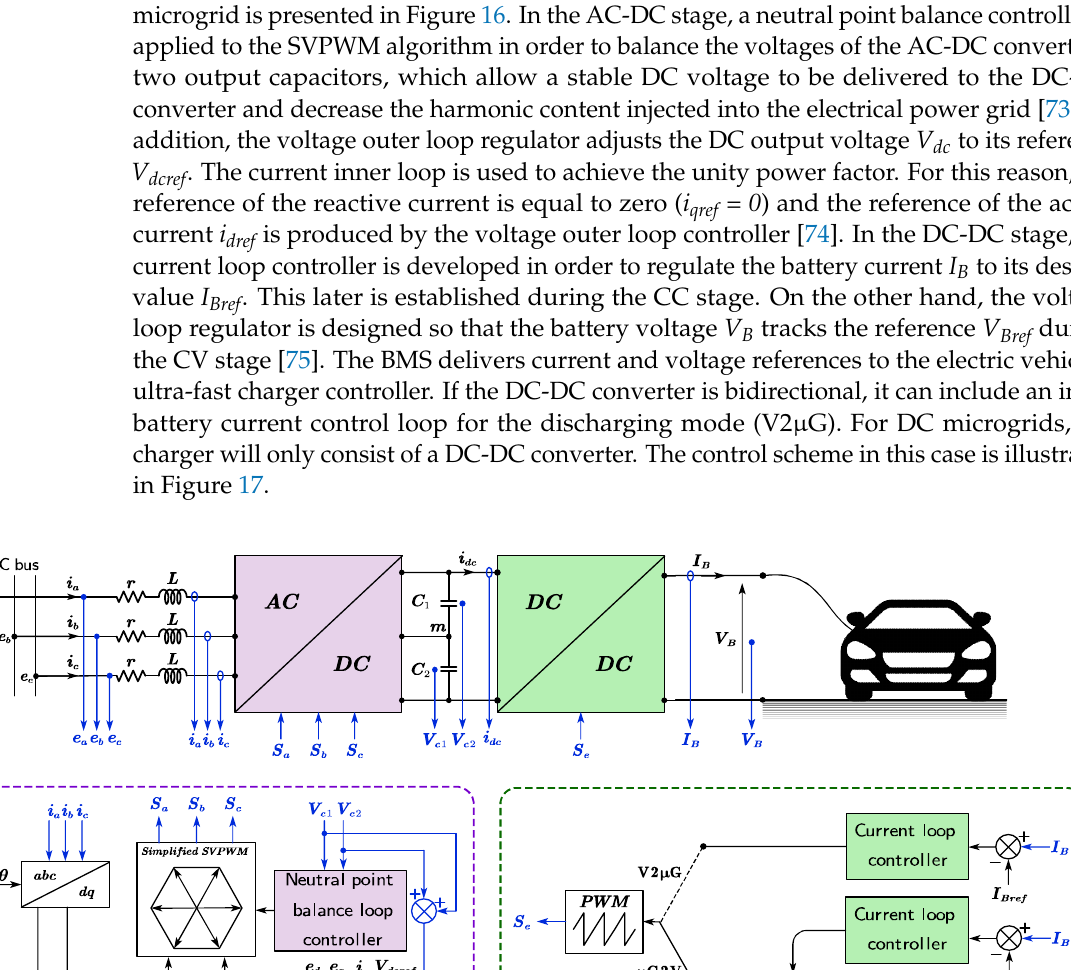
Figure 17. A control structural scheme of the ultra-fast charger integrated into the DC microgrid. Linear control techniques are widely applied to ultra-fast chargers thanks to their flexibility of adjustment, the practical implementation, and the simplified structure. Vari- ous types of linear controllers are available: Proportional Integral (PI) control technique, Proportional Resonant (PR) controller, Proportional Integral Derivative (PID) controller, Linear Quadratic Regulator (LQR) control algorithm, etc. Table 6 summarizes the various linear control techniques that have been proposed for ultra-fast chargers in the literature.